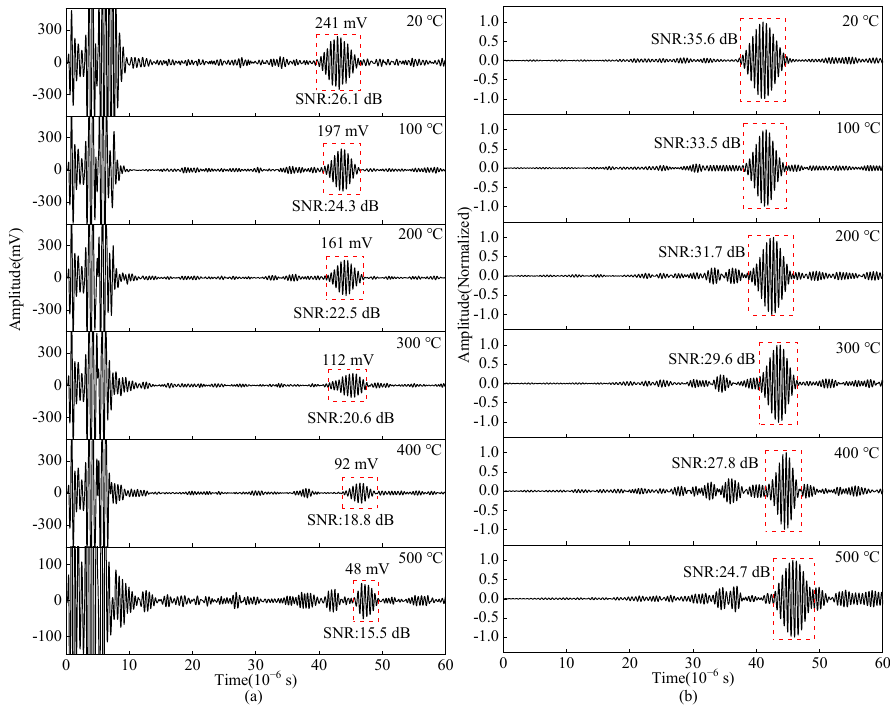
Figure 28. Crack-reflected wave obtained by ( a ) tone-burst excitation method ( b ) Barker code pulse compression technique in carbon steel specimens from 20 °C–500 °C.